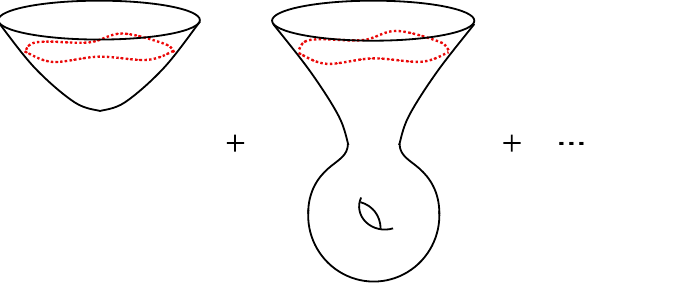
Figure 12 . The summation of all the possible smooth Euclidean geometries that asymptote to a \trumpet"